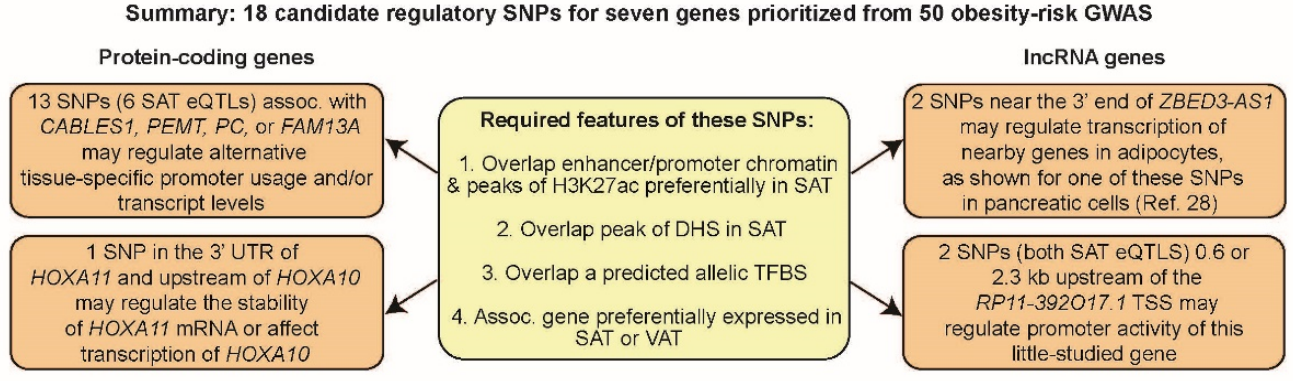
Figure 6. Summary of proposed functions of the 18 obesity-related prioritized candidates for regulatory SNPs (Tier-1 SNPs) and their epigenomic/transcriptomic associations. Assoc., associated; SAT, subcutaneous adipose tissue; VAT, visceral adipose tissue; eQTL, expression quantitative trait loci; 3’ UTR, 3’ untranslated region of mRNA or the corresponding DNA; H3K27ac, histone H3 lysine-27 acetylation, a marker of active enhancer or promoter chromatin; TFBS, transcription factor binding site; Ref. 28, Miguel-Escalada et al. 2019 [28].